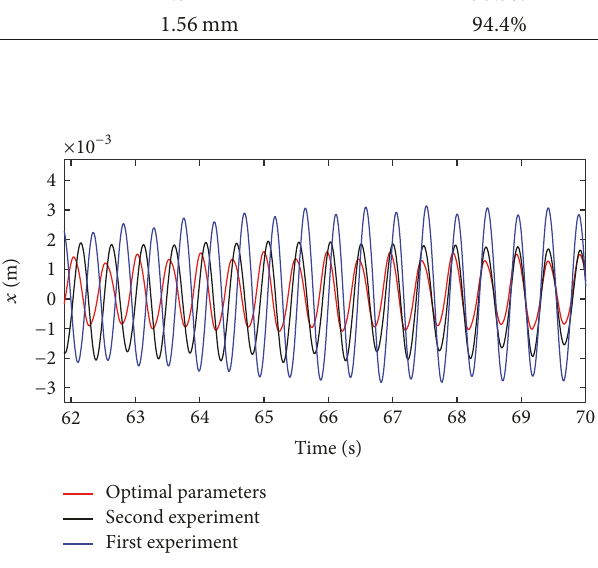
Figure 10: Steady state response comparison of the primary